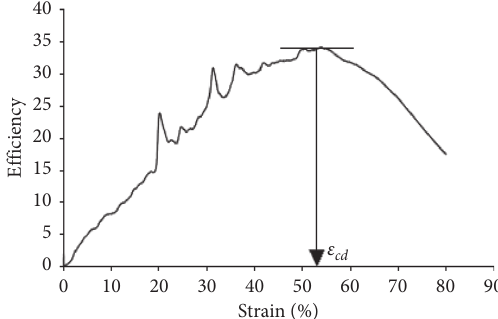
Figure 2: Energy absorption efficiency